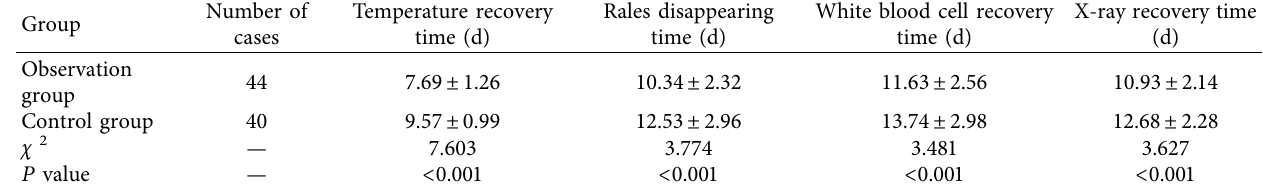
Table 4: Comparison of clinical symptoms improvement between the two groups ( x ± S ).